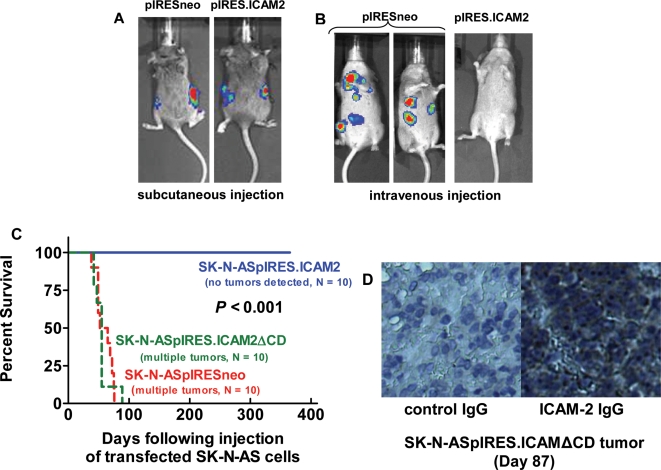
ICAM-2 expression inhibited the development of disseminated tumors but did not affect establishment or development of local subcutaneous tumors.A) ICAM-2 did not affect the growth of neuroblastoma cells as subcutaneous tumors in SCID mice, a measure of tumorigenic potential. B) ICAM-2 prevented the development of disseminated tumors, following intravenous tail vein injection of neuroblastoma cells, a measure of metastatic potential. C) Mice injected intravenously with SK-N-ASpIRES.ICAM-2 cells survived significantly longer (P<0.001) than mice receiving pIRESneo or pIRES.ICAM2ΔCD transfected cells. D) The failure of ICAM2ΔCD expression to suppress development of disseminated tumors was not due to cessation of expression of the transfected cDNA, since expression of ICAM-2ΔCD protein persisted until time of death.